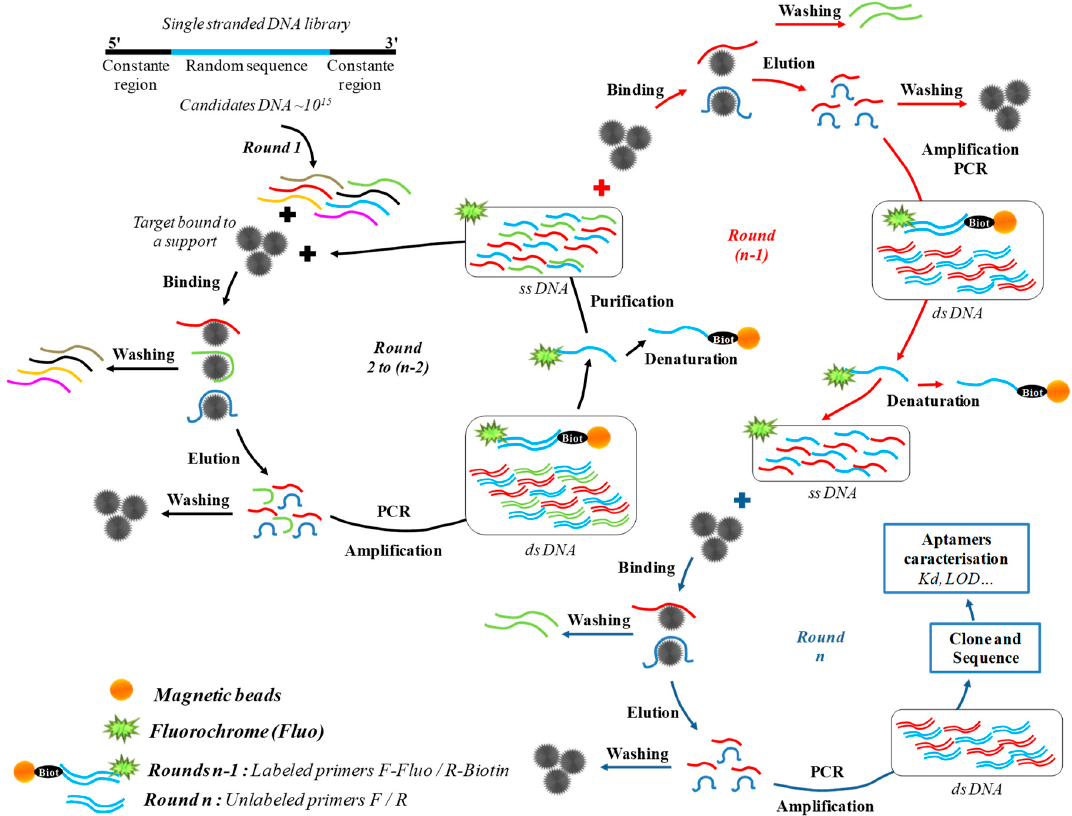
Figure 6. Synoptic representation of the SELEX method for DNA library. Three main stages constitute a general SELEX protocol, the incubation of the library with the target which is sometimes bound to a support, the separation of the oligonucleotides linked to the target from the unbound oligonucleotides from the library, and the amplification of the oligonucleotides linked to the target. For this representation, the primers are modified with a fluorochrome for the forward primer and with biotinylated magnetic beads. After the last stage, the amplified oligonucleotides (dsDNA) are denatured, in this representation, with the help of magnetic beads which are retained by a magnet, and therefore only the ssDNA tagged with the fluorochrome are used for the next round. The presence of the fluorochrome tracks the amounts of aptamers selected during the SELEX process. For RNA-SELEX, some additional steps are included first, i.e., an in vitro transcription to obtain an RNA library, and the reverse transcription of bound RNA molecules to obtain cDNA and its subsequent amplification.